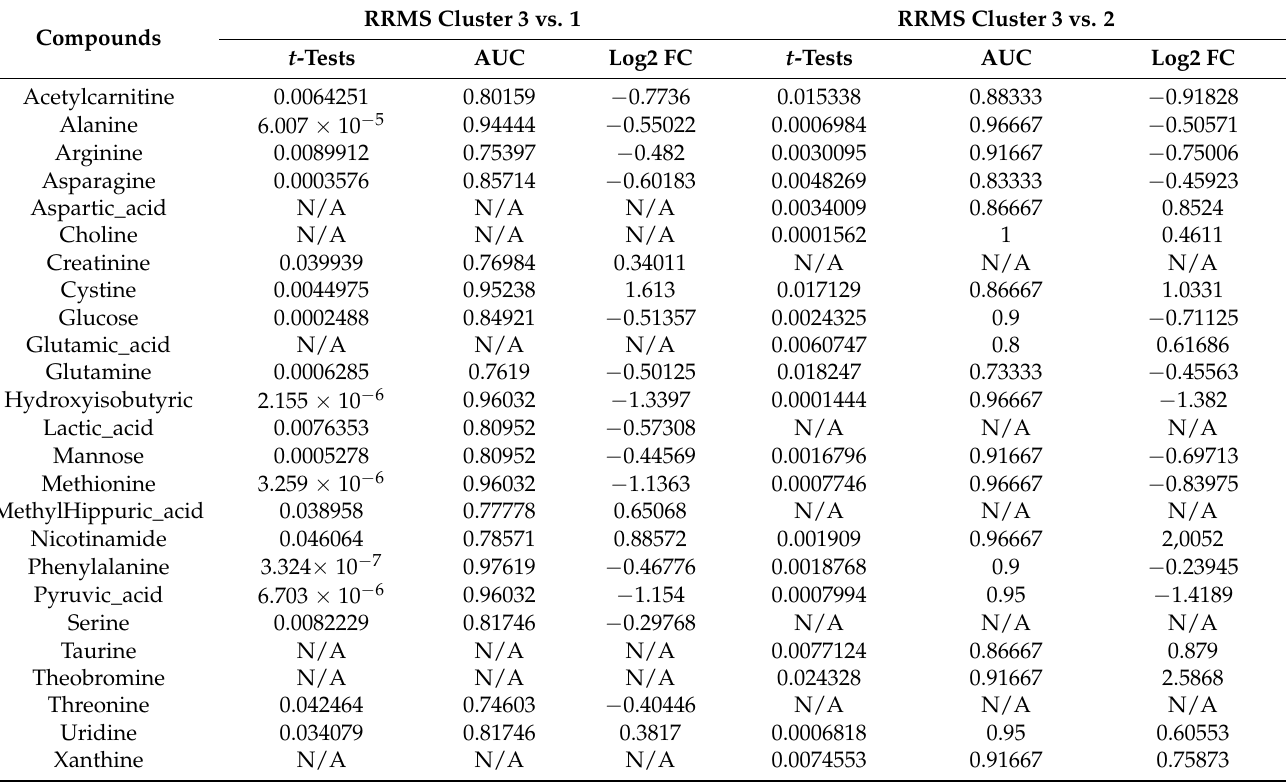
Table 4. Metabolites implicated in the differentiation between the sub-groups (clusters) of patients with Relapsing-Remitting Multiple Sclerosis, derived from Hierarchical Clustering analysis. RRMS Cluster 3 vs.